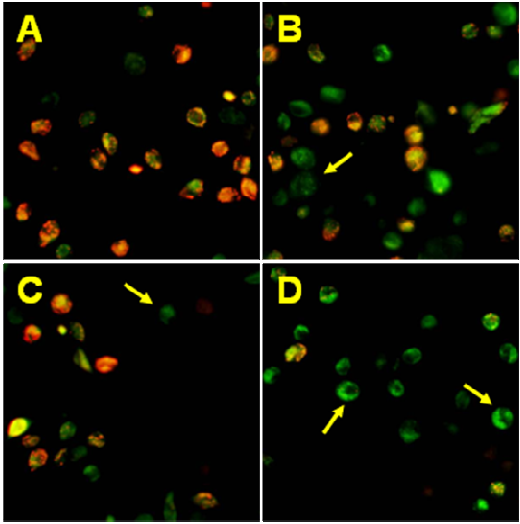
Figure 9. TRAIL in combination with chalcone altered the mitochondrial transmembrane potential ( ΔΨ m) and induced apoptosis in LNCaP prostate cancer cells. The cancer cells were incubated for 48 hours with TRAIL at the concentration of 100 ng/mL and chalcone at the concentration of 100 μ M. DePsipher has the property of aggregation upon membrane polarization forming a red fluorescent compound. If the potential is disturbed, the dye cannot access the transmembrane space and remains or reverts to its green monomeric form. The fluorescence is observed and analyzed by microscope. Apoptotic cells with loss ΔΨ m are indicated by arrows. (A) Control cells, (B) cells incubated with TRAIL (100 ng/mL), (C) cells incubated with chalcone (100 μ M), (D) cells incubated with TRAIL (100 ng/mL) and chalcone (100 μ